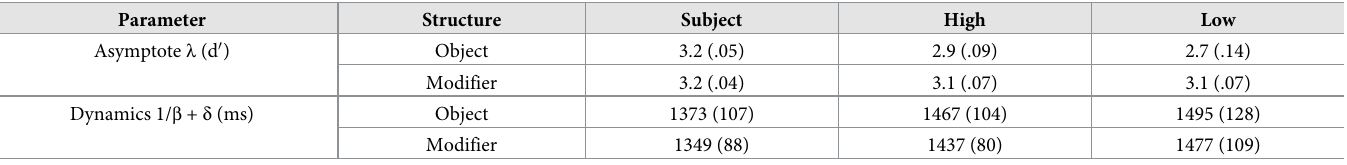
Table 6. Summary of participant parameter estimates in Experiment